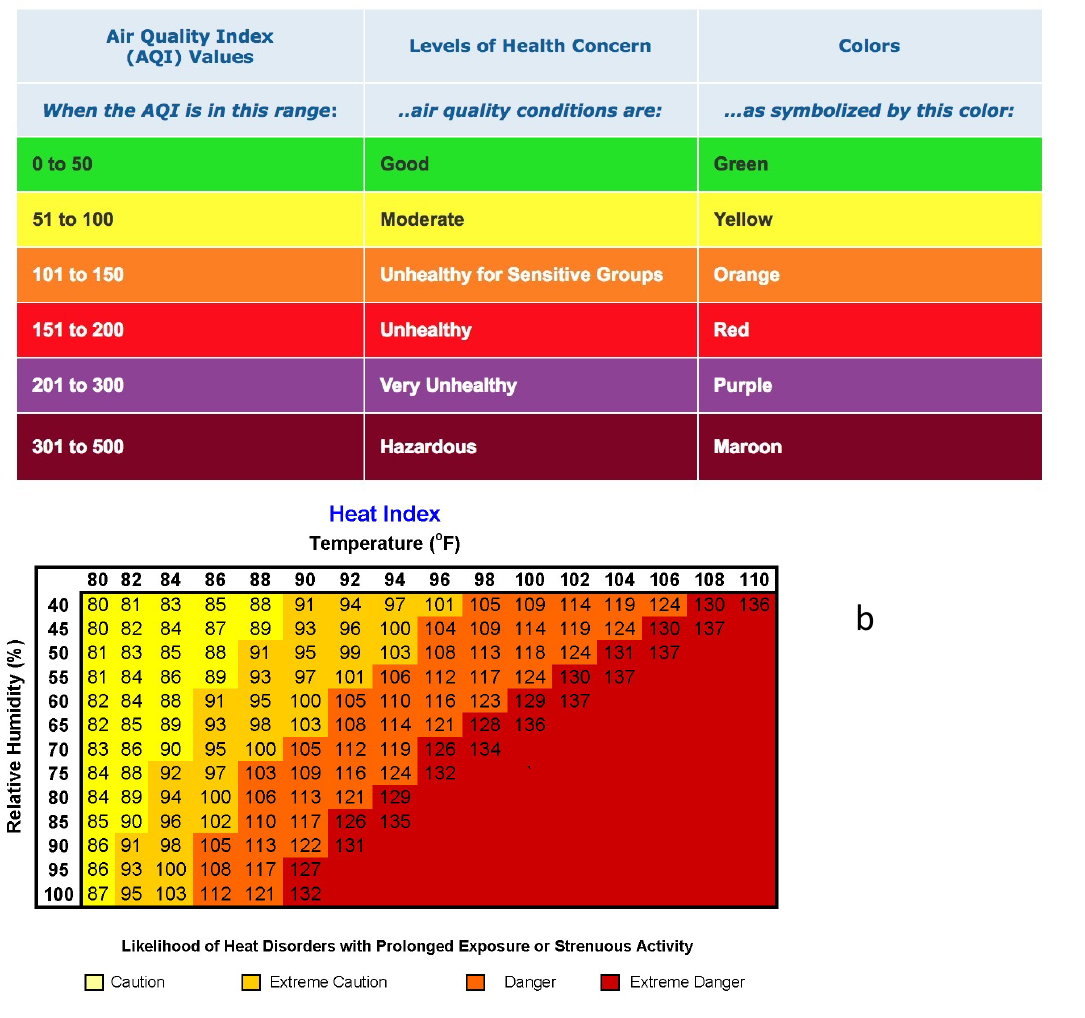
Figure 1. ( a ) Air quality index (AQI) chart (airnow.gov/aqi/aqi-basics, accessed on 1 March 2022), ( b ) heat index (HI) chart (www.weather.gov/phi/heatcond, accessed on 1 March 2022).